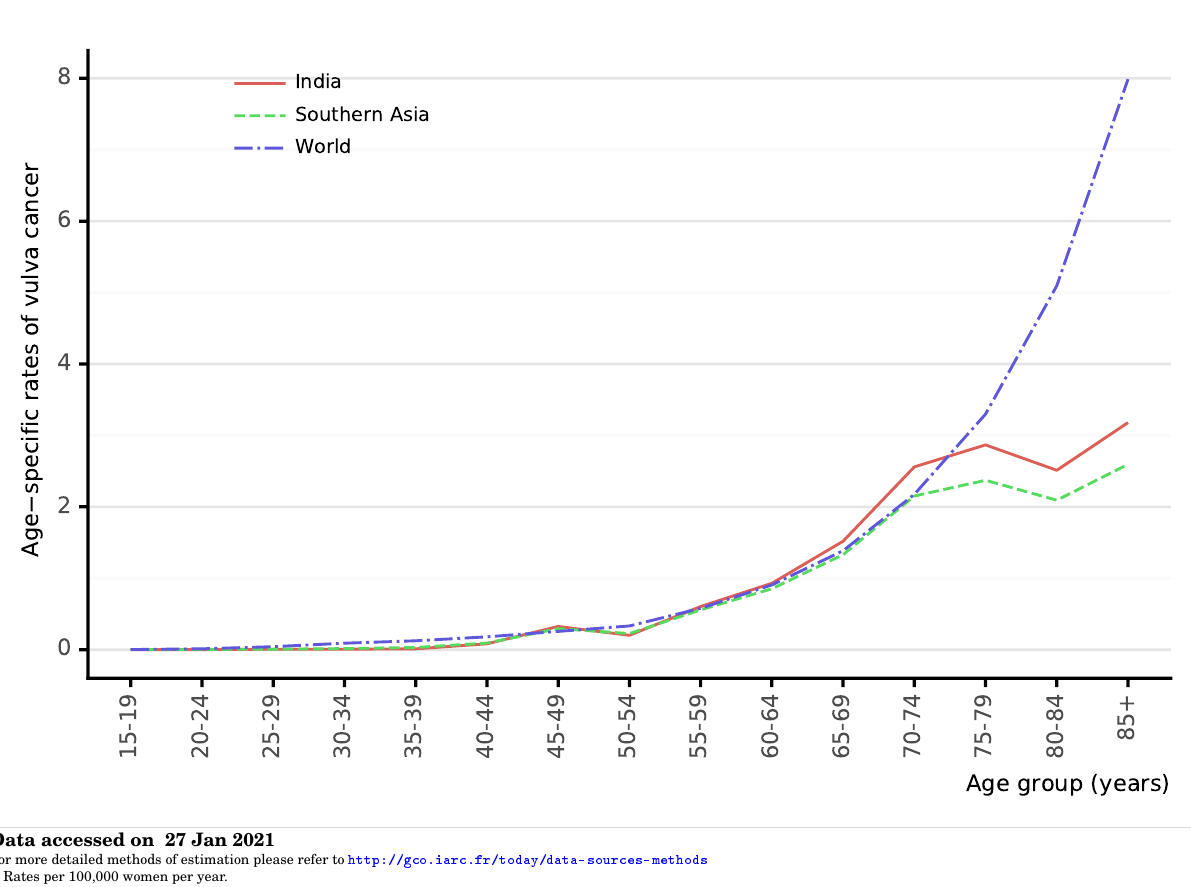
Figure 115: Comparison of age-specific vulva cancer mortality rates in India, within the region, and the rest of